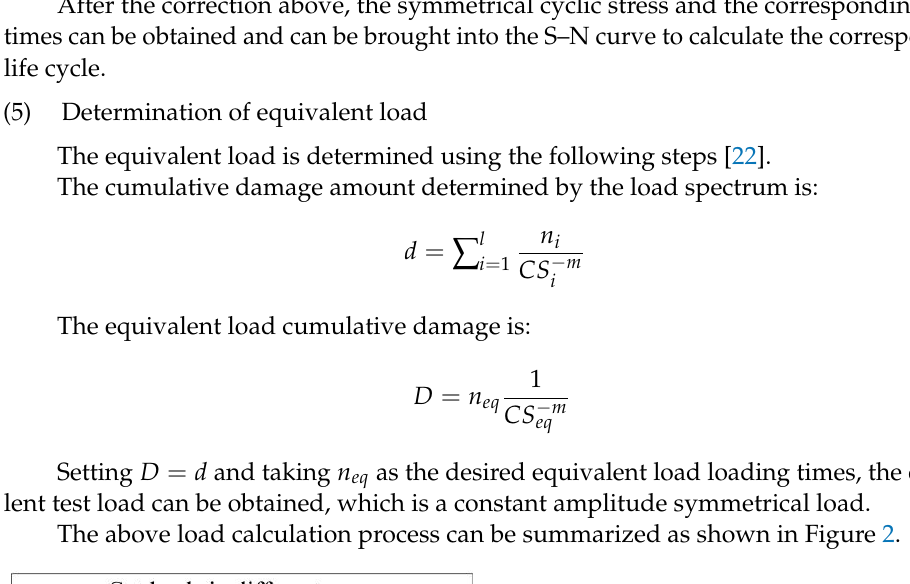
Figure 1. Goodman Guidelines.